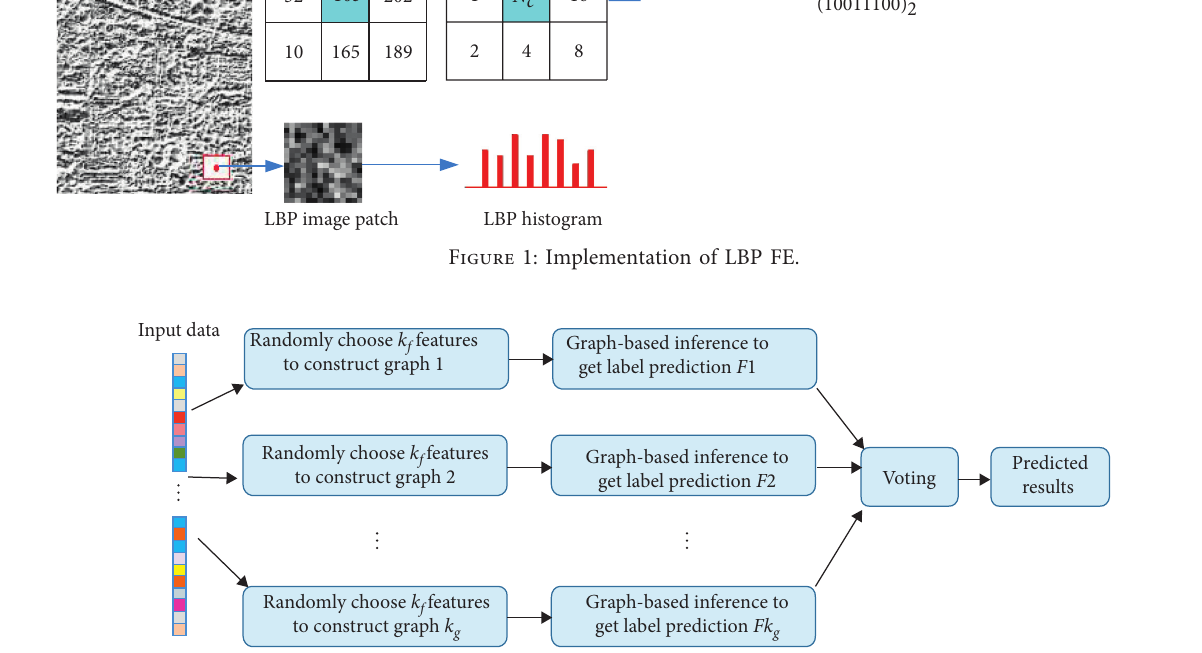
Figure 2: Flowchart of the